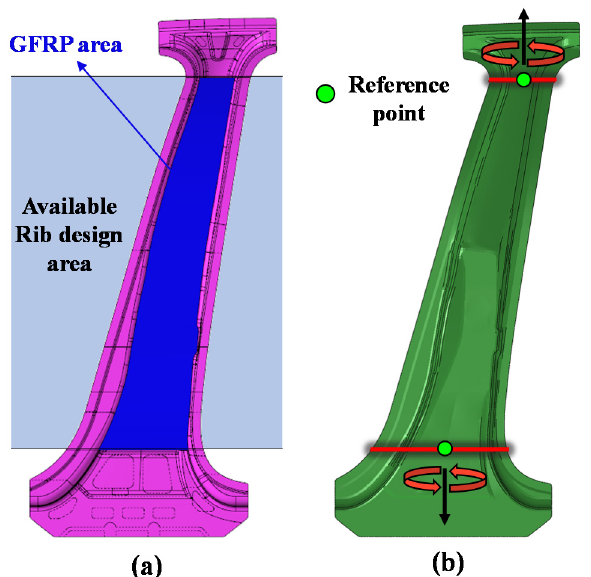
Figure 8. ( a ) Available rib design area and ( b ) topology optimization analysis conditions.